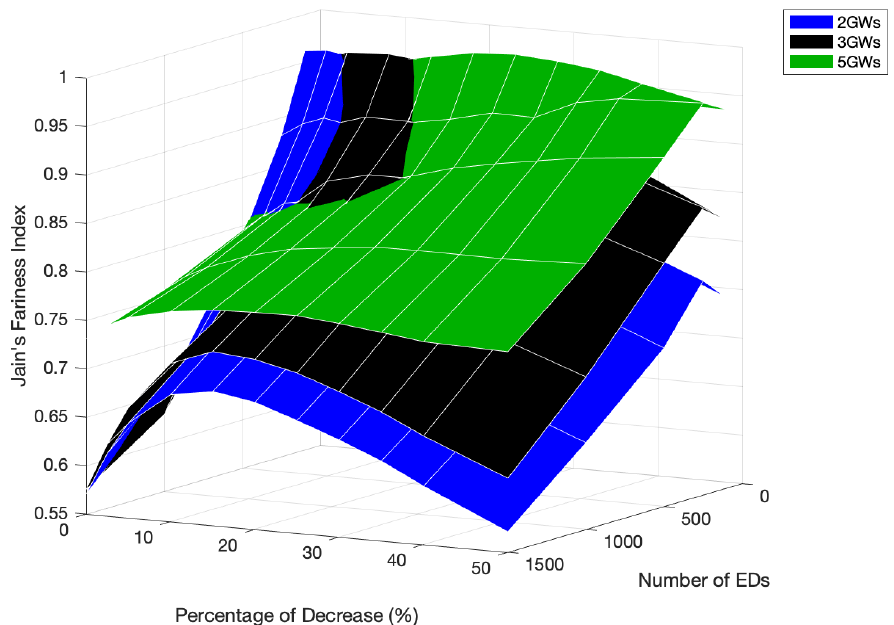
Figure 18. Network fairness comparison for different numbers of GWs, network sizes, and PoD.